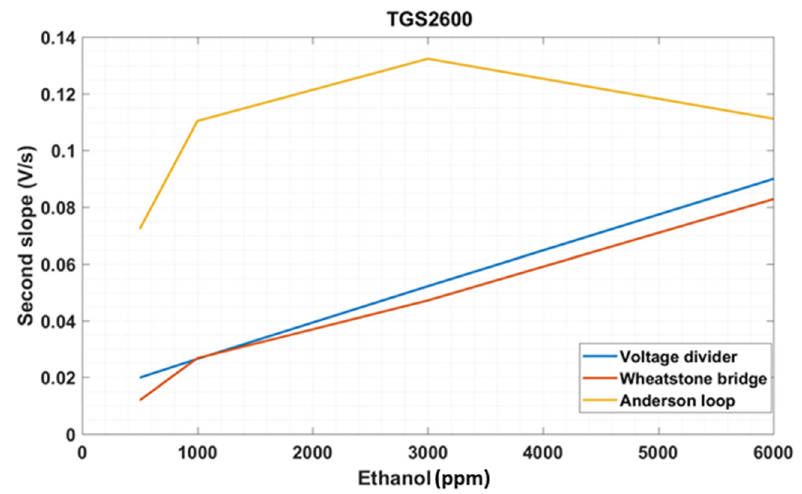
Figure 14. Value of second slope measured with the TGS 2600 in the rising edge.